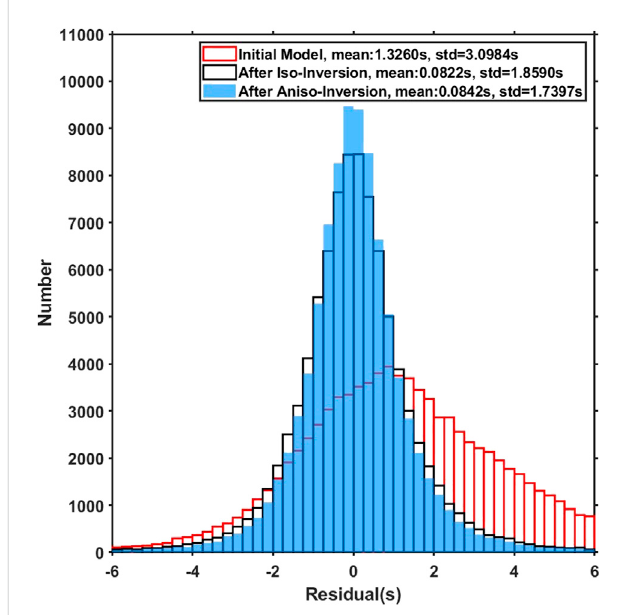
FIGURE 4 The distributionofRayleighwave travel-time residuals for theinitial model(redbar),afterisotropicinversion(blackbar),andafteranisotropic inversion (blue bar). “ Mean ” and “‘ std ” show the average and standard deviation values of residuals at different inversion